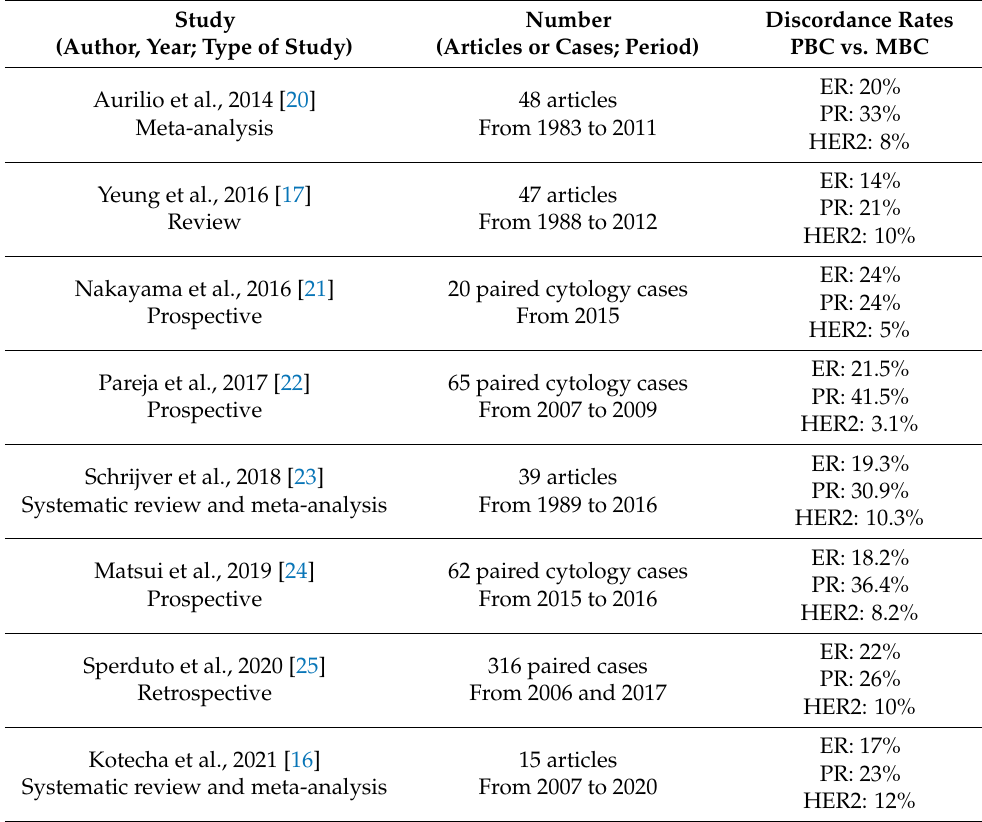
Table 1. Studies on the discordance of immunochemical biomarkers between primary breast carcino- mas and corresponding